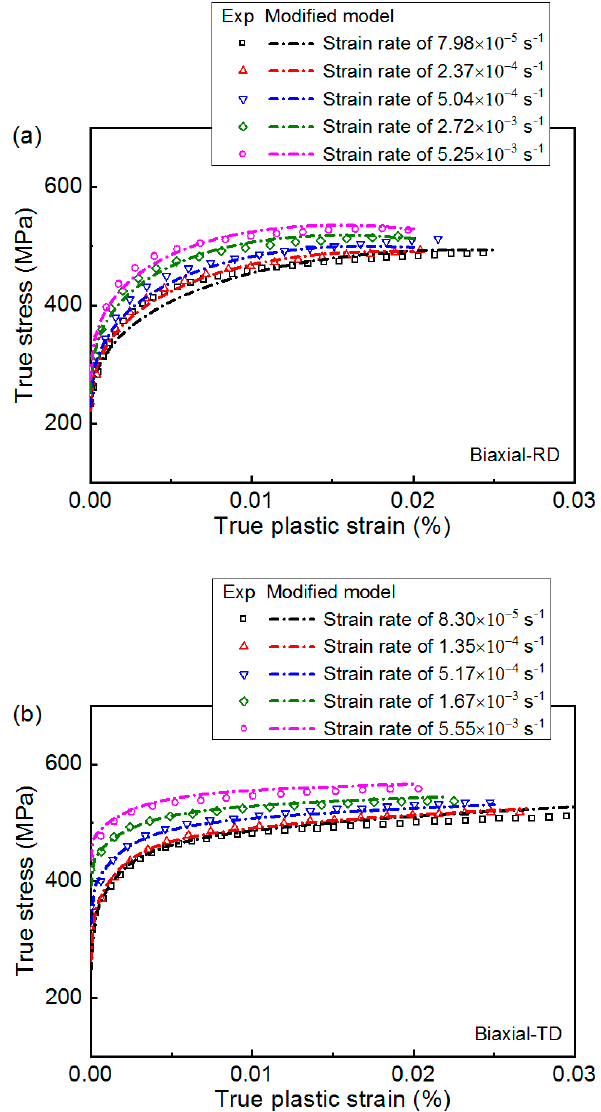
Figure 15. Comparison of predicted tensile curves of the proposed model and experimental tensile curves at biaxial RD ( a ) and TD ( b ). Table 6. Mean absolute error (MAE) and root mean square error (RMSE) between predicted and experimental data. Model